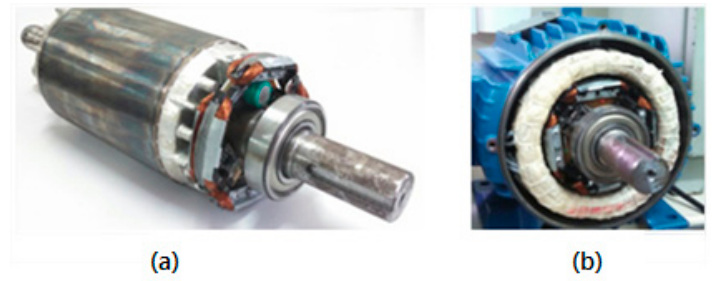
Figure 9. System coupled to the rotor. ( a ) Outside the stator; ( b ) inside the stator.